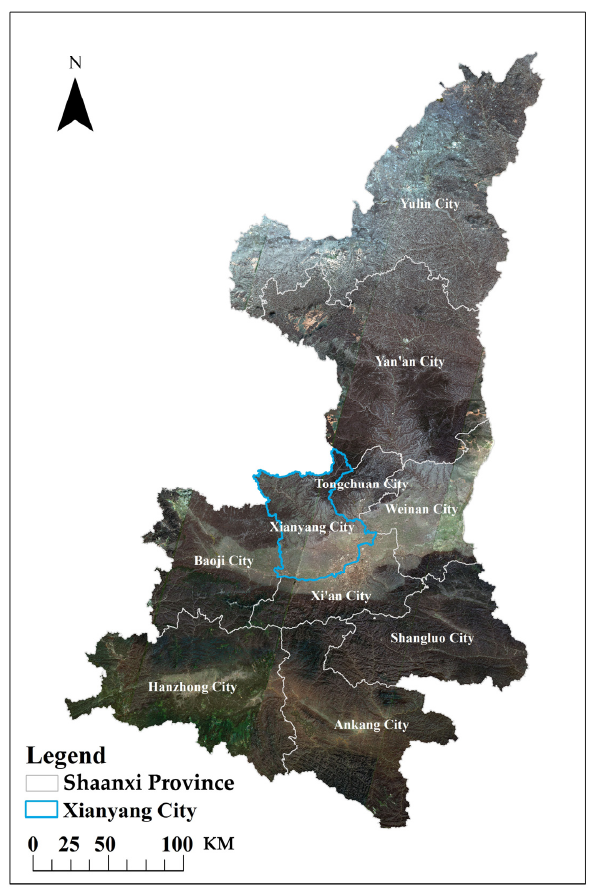
Figure 1. Xianyang City, Shaanxi Province.